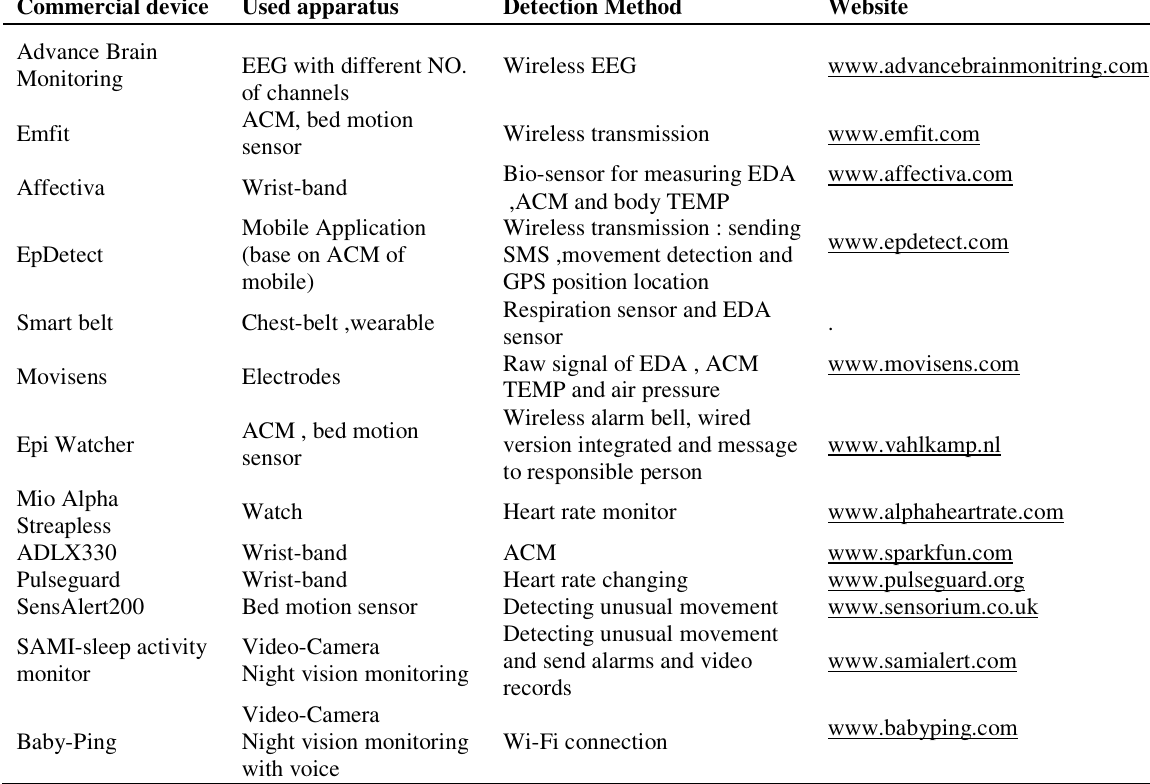
Table 1.2 Review of different commercial